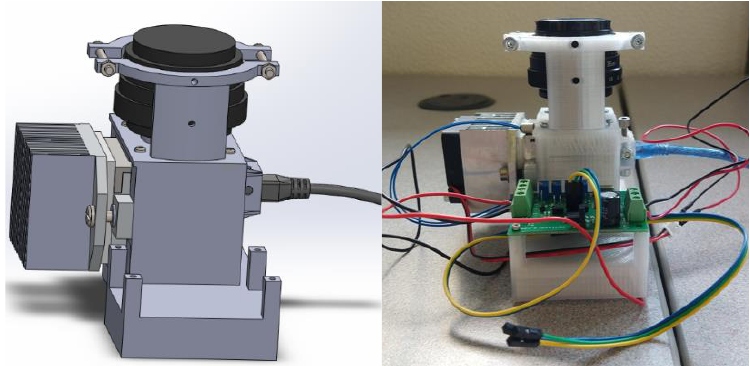
Figure 2. Mechanical design and assembled breadboard.